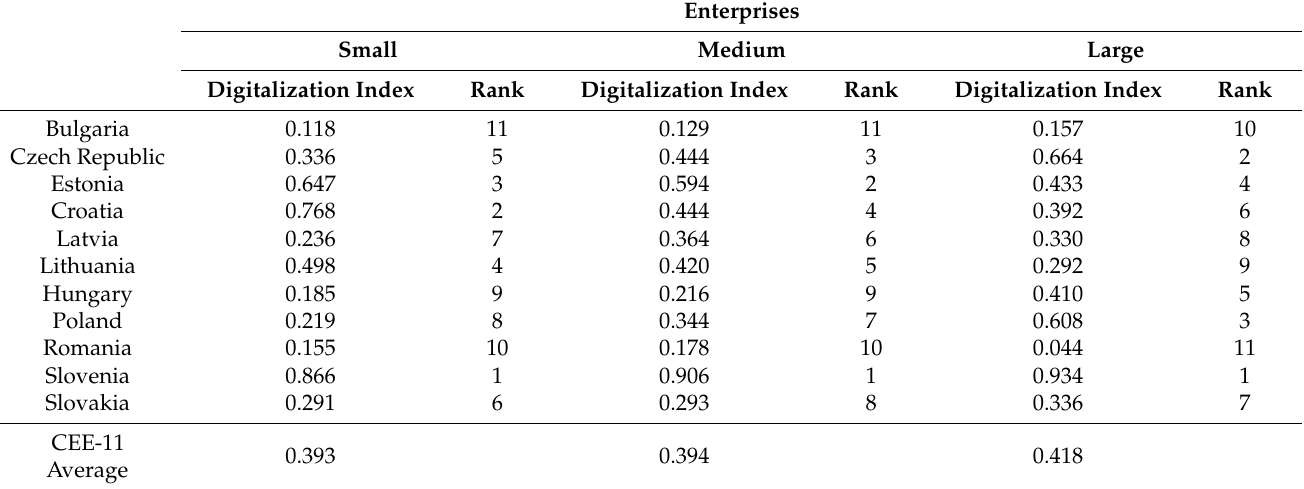
Table 10. Ranking of the CEE countries in terms of the level of digitalization of individual groups of enterprises determined by the VIKOR